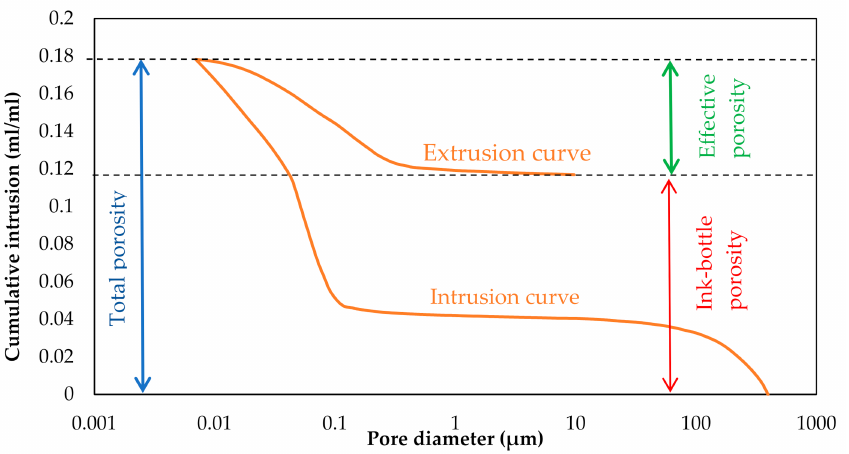
Figure 6. Example of intrusion and extrusion mercury intrusion porosimetry (MIP)